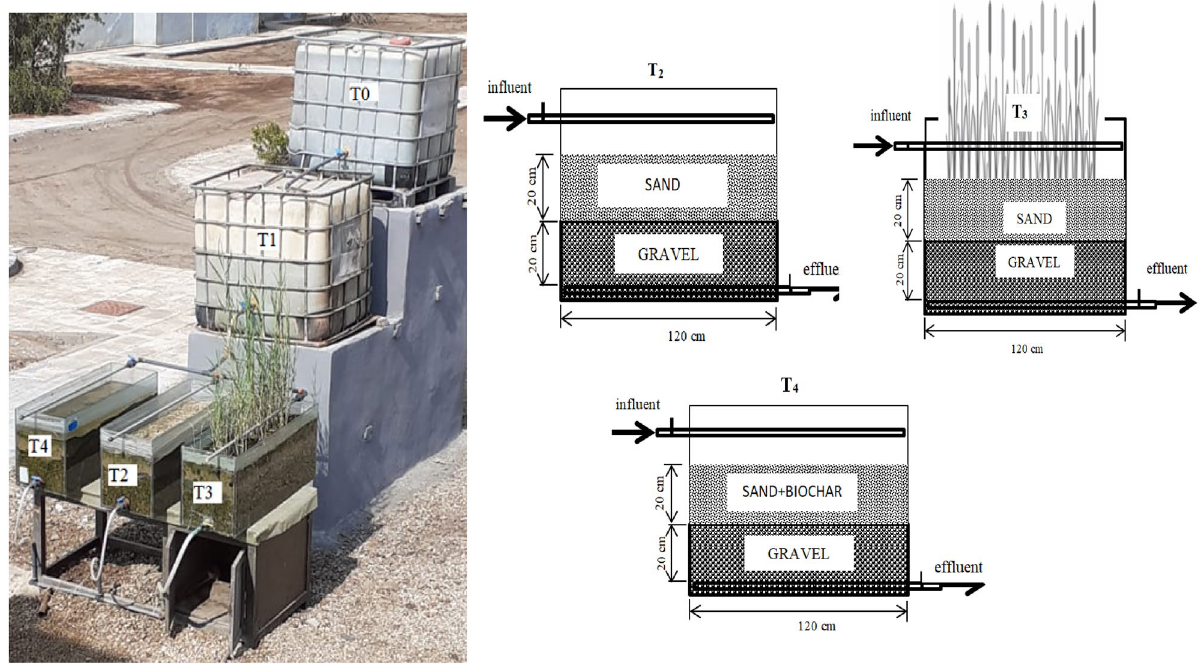
Figure 1. Schematic diagrams of the treatment cells using sand and gravel beds (T 2 ) grown with common reed plants (T 3 ) and mixed with biochar (T 4